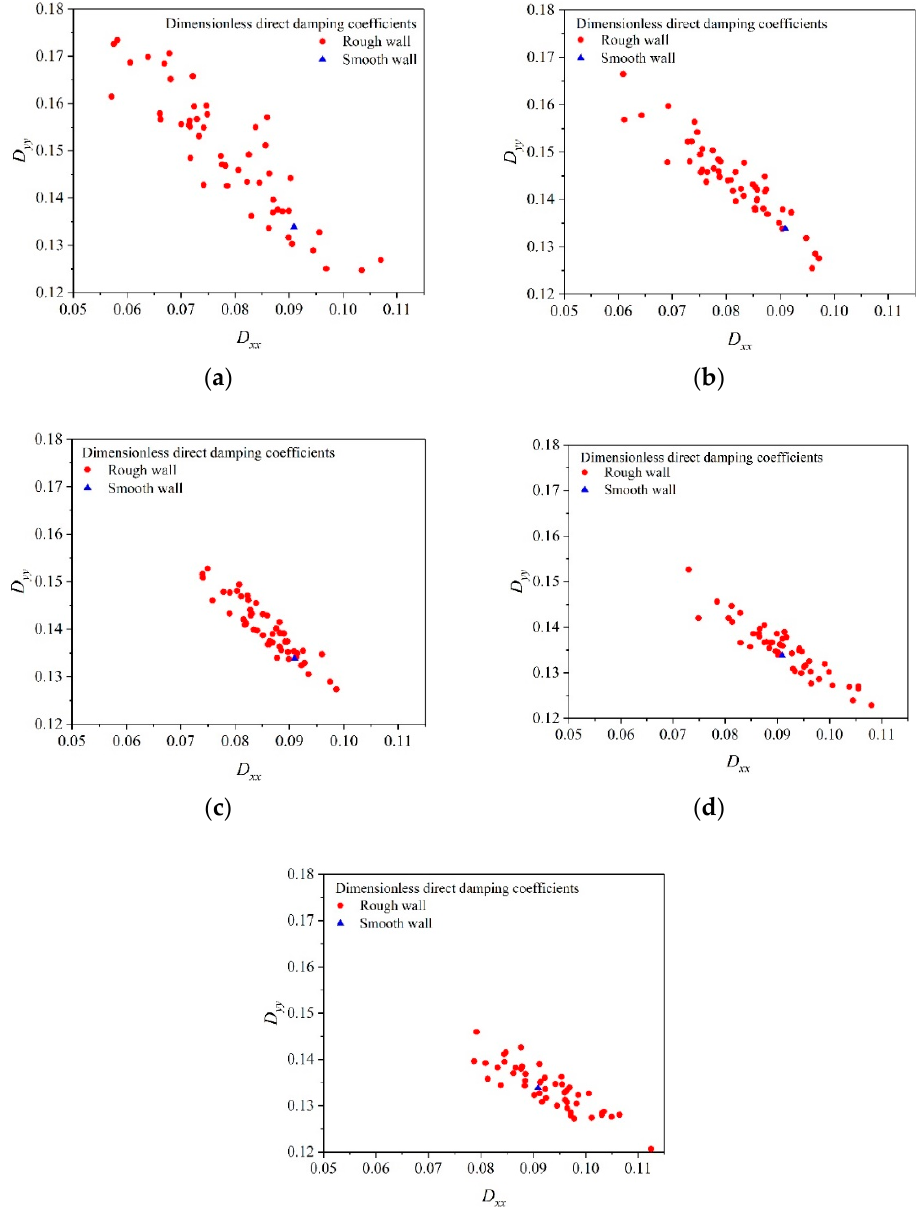
Figure 11. Direct damping coefficients distribution with wear in axial regions. ( a ) axial region 1. ( b ) axial region 2. ( c ) axial region 3. ( d ) axial region 4. ( e ) axial region 5.